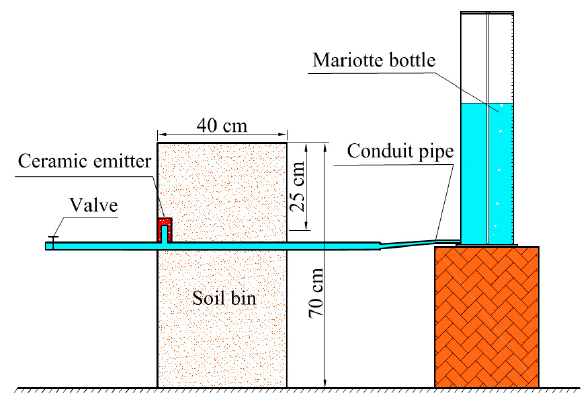
Figure 2. Schematic diagram of the experimental device.